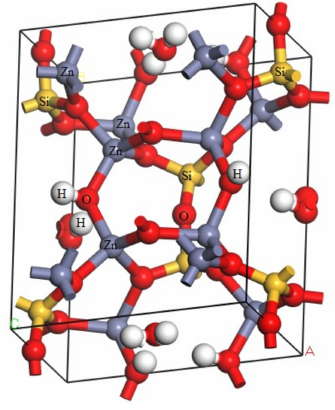
Figure 2. Cell model of